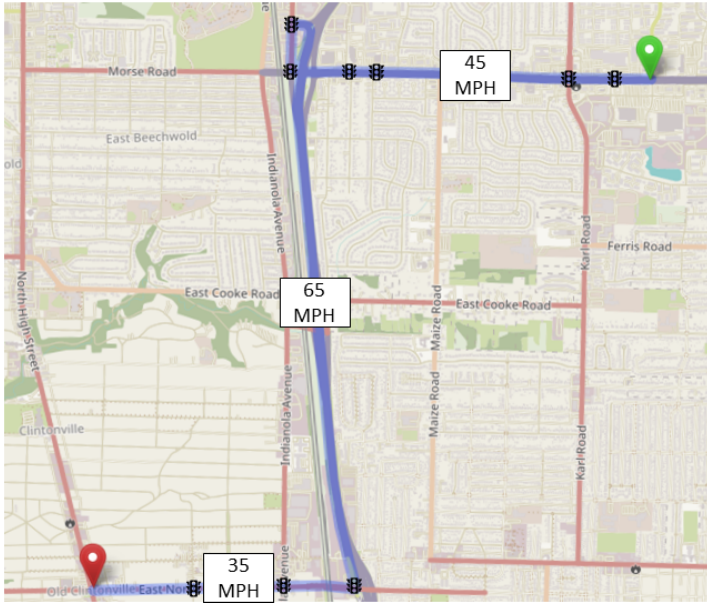
Figure 6. Map of route.